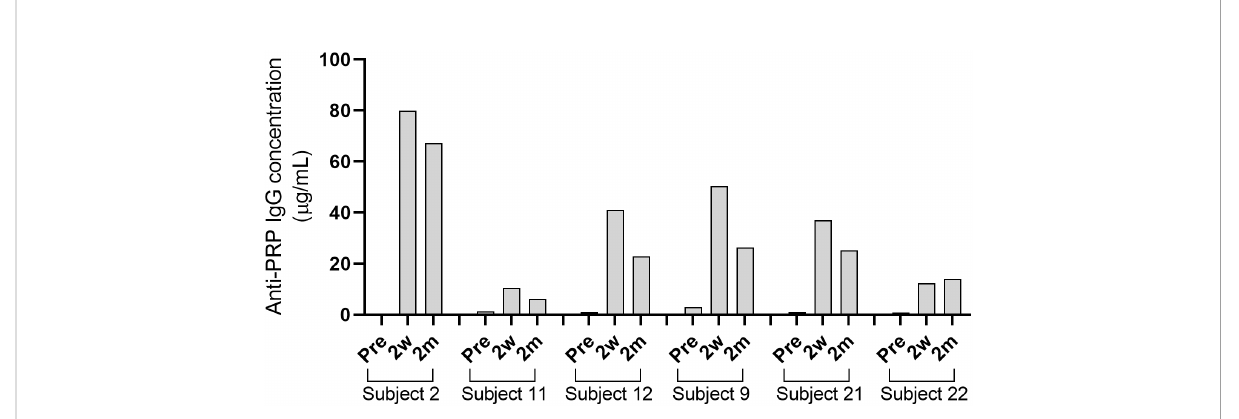
FIGURE 1 Concentrations of anti-PRP IgG after vaccination with ActHIB. Serum samples were taken before vaccination (Pre), 2 weeks (2w) and 2 months (2m) post-vaccination. Each bar represents the average result of two measurements against the PRP